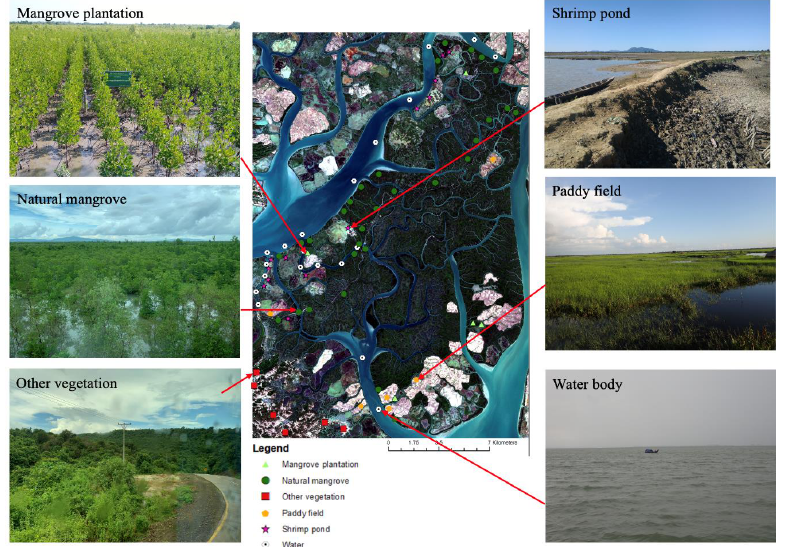
Figure 2. Ground location points of different land covers of mangrove plantation, natural mangrove, other vegetation, shrimp pond, paddy field, and water body (Photos were taken by Win Sithu Maung during the field survey of this study.). To assess natural recovering mangroves in abandoned shrimp ponds and to ensure the identification of natural recovery sites, we set 3 criteria: (1) No planted mangroves, (2) Remote Sens. 2021 , 13 , x FOR PEER REVIEW same abandonment year, and (3) site accessibility. Three disused ponds, which met these criteria, were selected after discussions with the local staff of the Forest Department and the pond owners (Figure 3). The locations of these abandoned ponds were collected to create polygons of the recovered ponds. Recovering mangrove species at the selected abandoned sites were observed by conducting a field inventory in 50 sample plots with the assistance of knowledgeable local laborers and Forest Department staff (Figure 3).